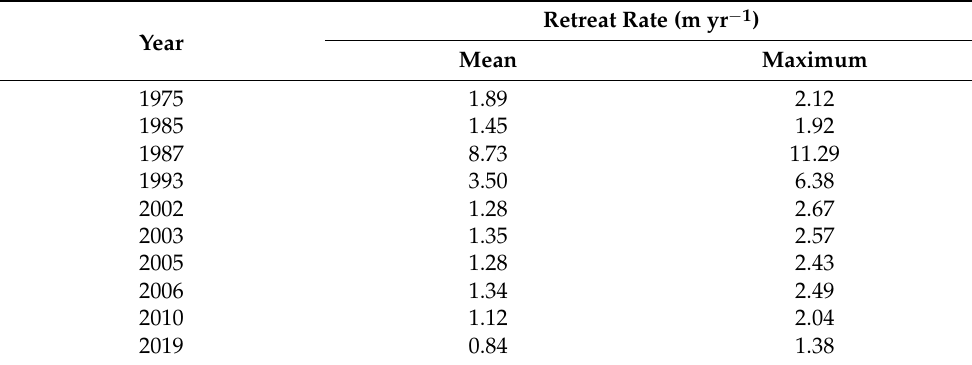
Table 7. Retreat rate of the landslide scarp at Site 2. See also Figure